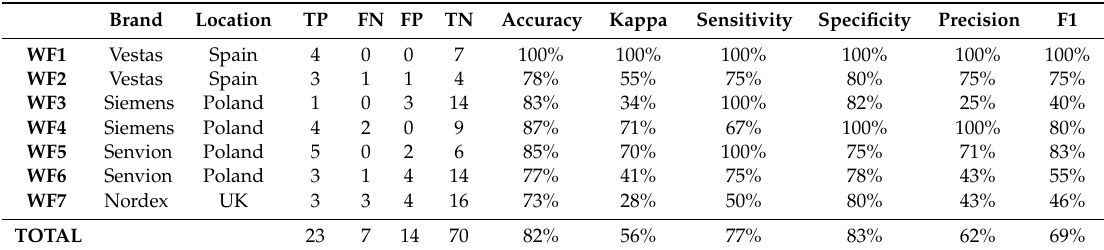
Table 6. Key Performance Indicators (KPIs) results summary for all the available windfarms (WF), sorted by turbine manufacturer (Brand) and location. TP stands for True Positive, FN False Negative, FP False Positive and TN True Negative.